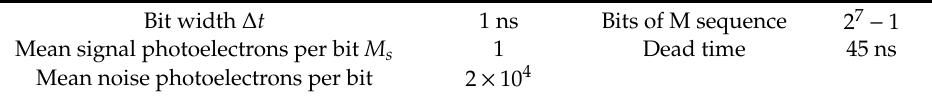
Table 1. Simulation parameters of pseudo-random single-photon detection. Bit width ∆